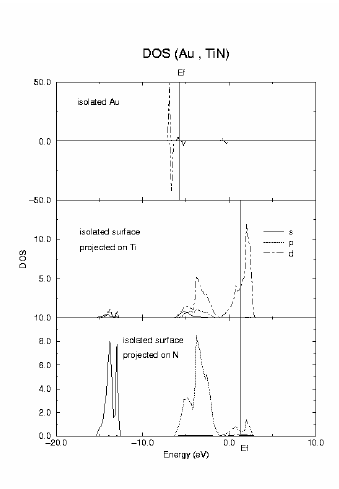
Figure 4. DOS curves for Au atom (top) and a slab of TiN (001) surface (middle and